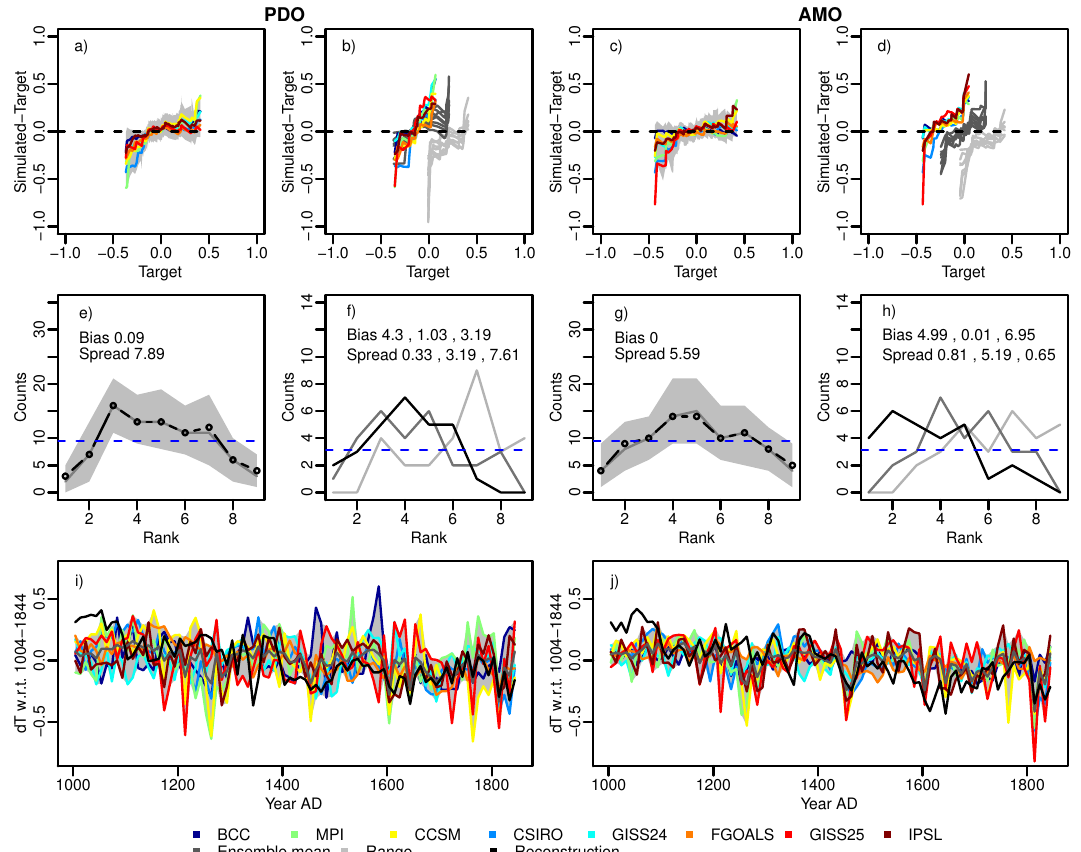
Fig. 5. Consistency of the indices for the North Pacific (PDO) and North Atlantic (AMO) regions. (a–d) Residual quantile-quantile plots (in K) for (a, c) the full period and (b, d) three sub-periods (defined as for Fig. 2) of 28 records (early, light grey, middle, dark grey, late, coloured). (e–h) Rank histogram counts for (e, g) the full period and (f, h) the three sub-periods (light grey to black). Numbers are the χ 2 statistics for the periods. In (f, h) numbers refer, from left to right, to the early to late sub-periods. Blue horizontal lines give the expected average count for a uniform histogram. (i, j) Time series of the indices (in K) constructed from non-overlapping decadal means. Colour code as in legend except for shading. Shading for residual quantiles and rank counts (a, c, e, g) gives the 90% envelope of block bootstrapping 2000 replicates of block length 5. Residual quantile plots show on the x axis the quantiles of the target and on the y axis the difference between simulated and target